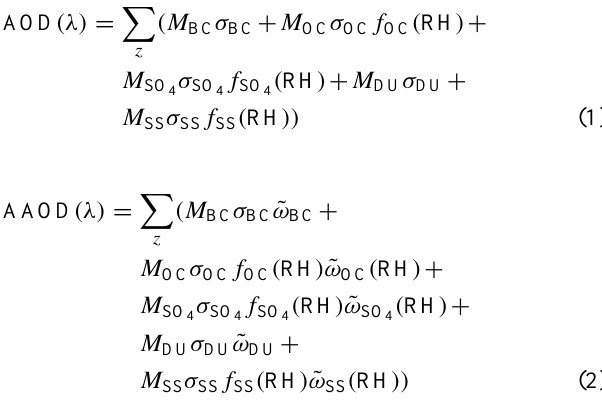
Figs. 1a and c. Same as HIGHEX but optical properties of OC and BC treated as dry